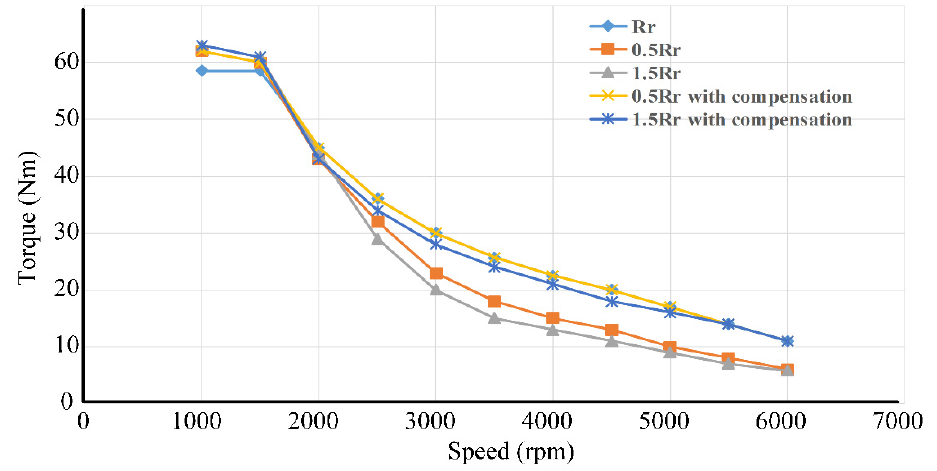
Figure 13. Maximum output torque from 1000 rpm to 6000 rpm.